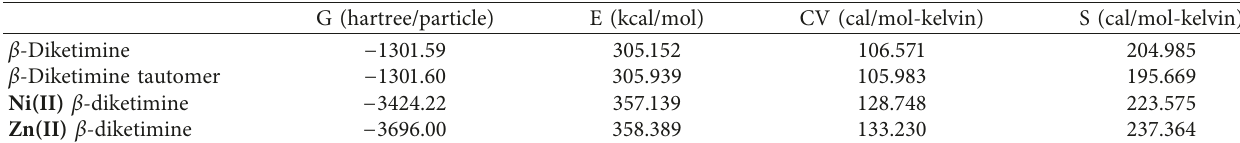
Table 5: Free energy (G), E (thermal), CV, and entropy (S) calculated for structures 1 , 2, & 3 . G